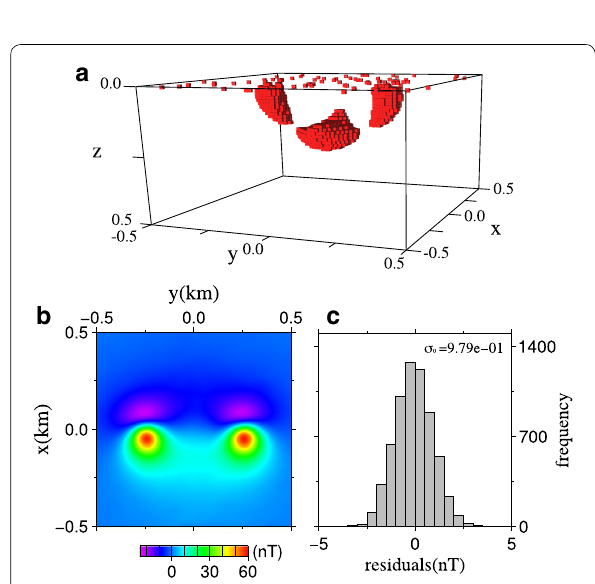
Fig. 8 An optimal model derived by L1–L2 norm regularized inversion. An optimal model derived by L1–L2 norm regularized α S 1 0.96 using weighting function w S 1 . a A inversion with ˆ = perspective view of the optimum model which displays all non-zero model elements, b total field anomaly computed by this model, and c histogram of the